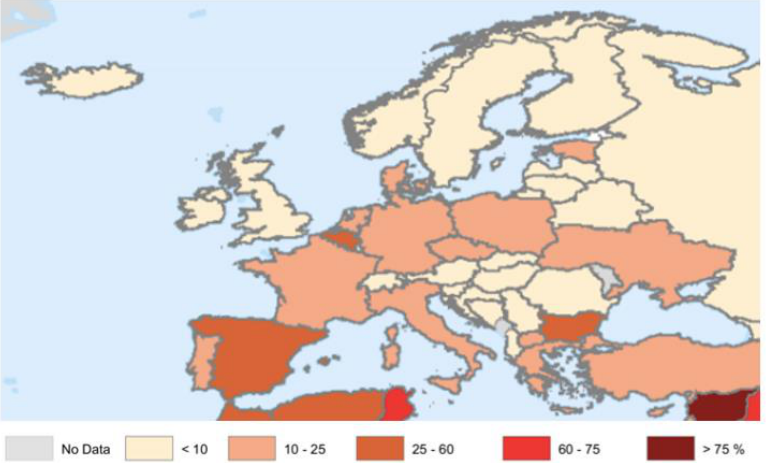
Figure 1. Proportion of renewable water resources withdrawn by EU members (2015). Source: AQUASTAT maps database [4].